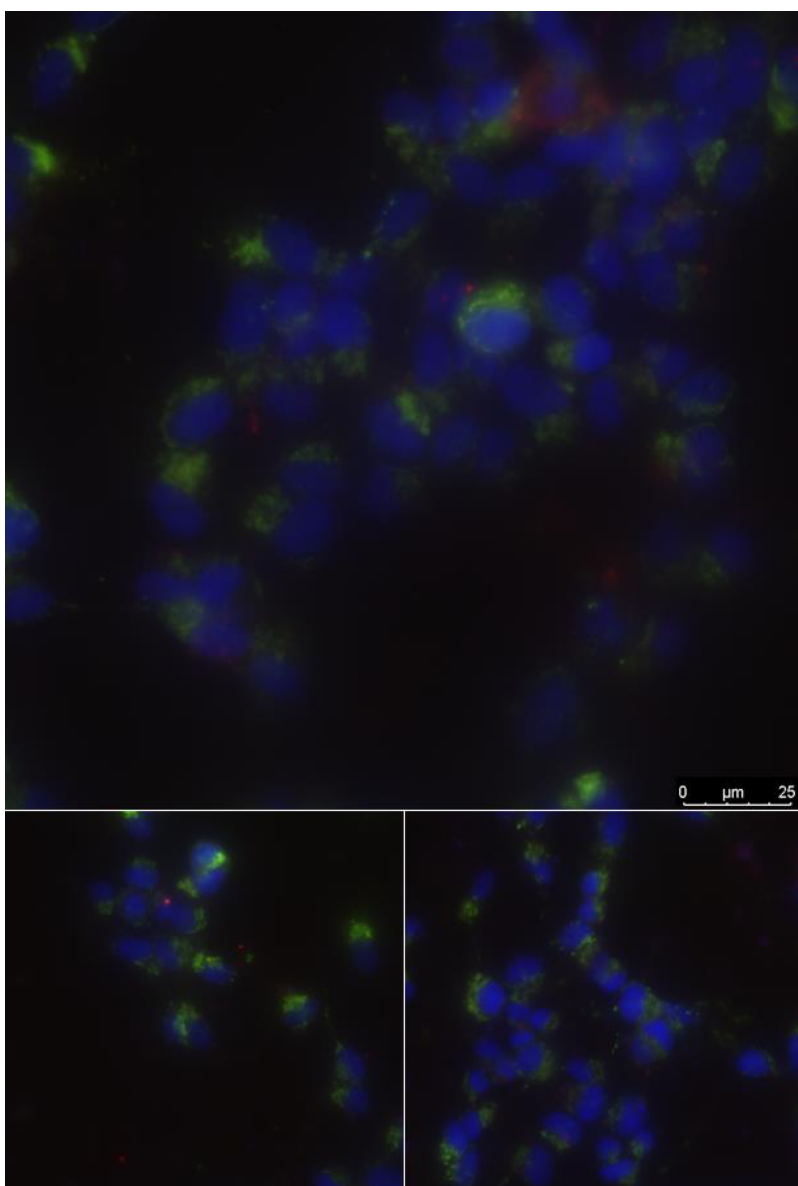
Figure 14. Cell culture on a Ti–Nb–Zr alloy sample. Channel overlay (Hoe fluorescence—blue nuclei of living cells, propidium iodide (PI) fluorescence—red dead cells, fluorescence MitoTracker Deep Red (MTDR)—green cell mitochondria). Several random sections of the sample.